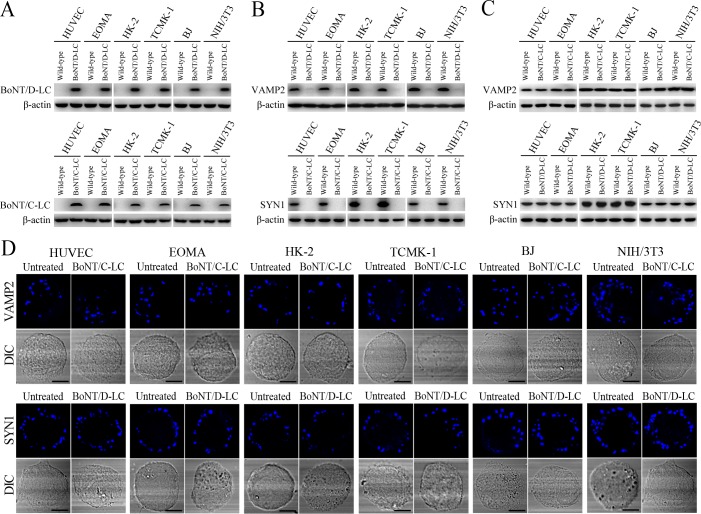
VAMP2/SYN1 cleavage by BoNT/D-LC/BoNT/C-LC transfection and VAMP2/SYN1 expression in BoNT/C-LC-/BoNT/D-LC-transfected cells.(A) The expressed BoNT/D-LC or BoNT/C-LC in the pcDNA3.1BoNT/C-LC- or pcDNA3.1BoNT/D-LC-transfected cells, determined by Western Blot assay. (B) Absence of VAMP2 or SYN1 in the BoNT/D-LC- or BoNT/C-LC-expressed cells, determined by Western Blot assay. (C) Expression of VAMP2 in the BoNT/C-LC-transfected cells and SYN1 in the BoNT/D-LC-transfected cells, determined by Western Blot assay. (D) Fluorescence staining of VAMP2 in the BoNT/C-LC-transfected cells and SYN1 in the BoNT/D-LC-transfected cells, determined by confocal microscopy (scale bars = 5 μm).